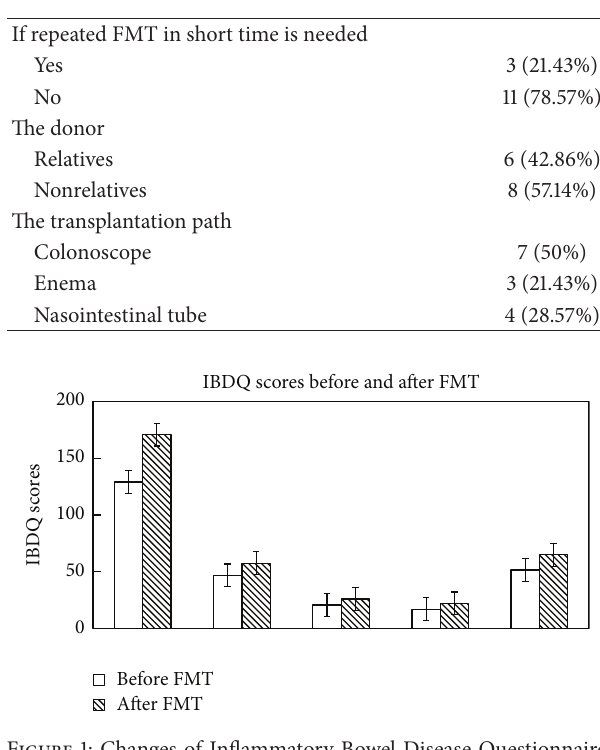
Figure 1: Changes of Inflammatory Bowel Disease Questionnaire score before and 4 weeks after fecal microbiota